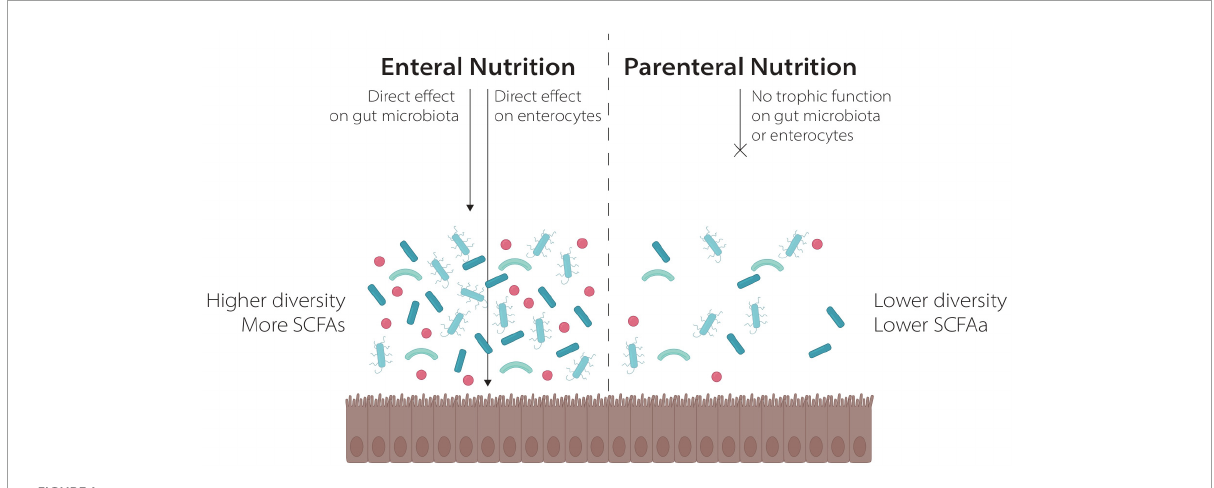
FIGURE1 The effect of Enteral and Parenteral Nutrition on the gut